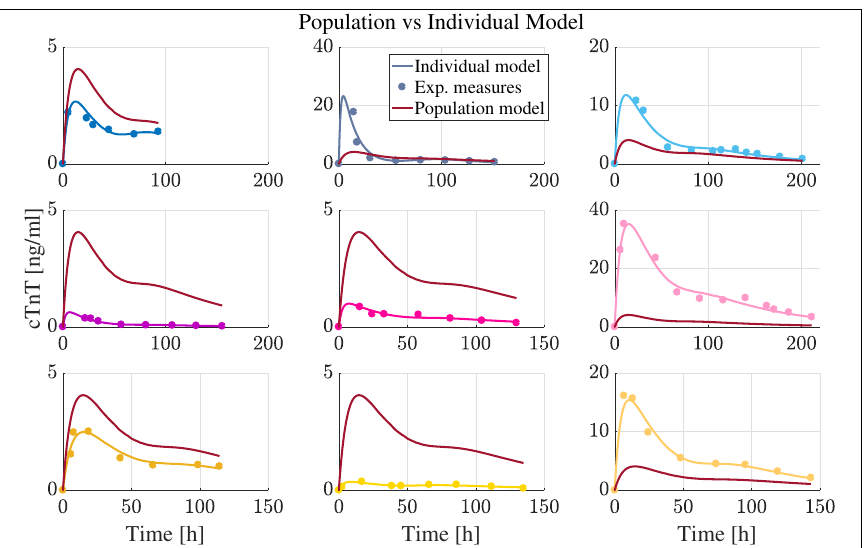
Figure 6. Model results for some of the 27 STEMI patients. For each subject, the population model (red light line), obtained by the fixed effects estimated from all the patients, and the individual fit (colorful line), obtained by taking into account the random effects, are reported. The experimental acquisitions are denoted by dots.